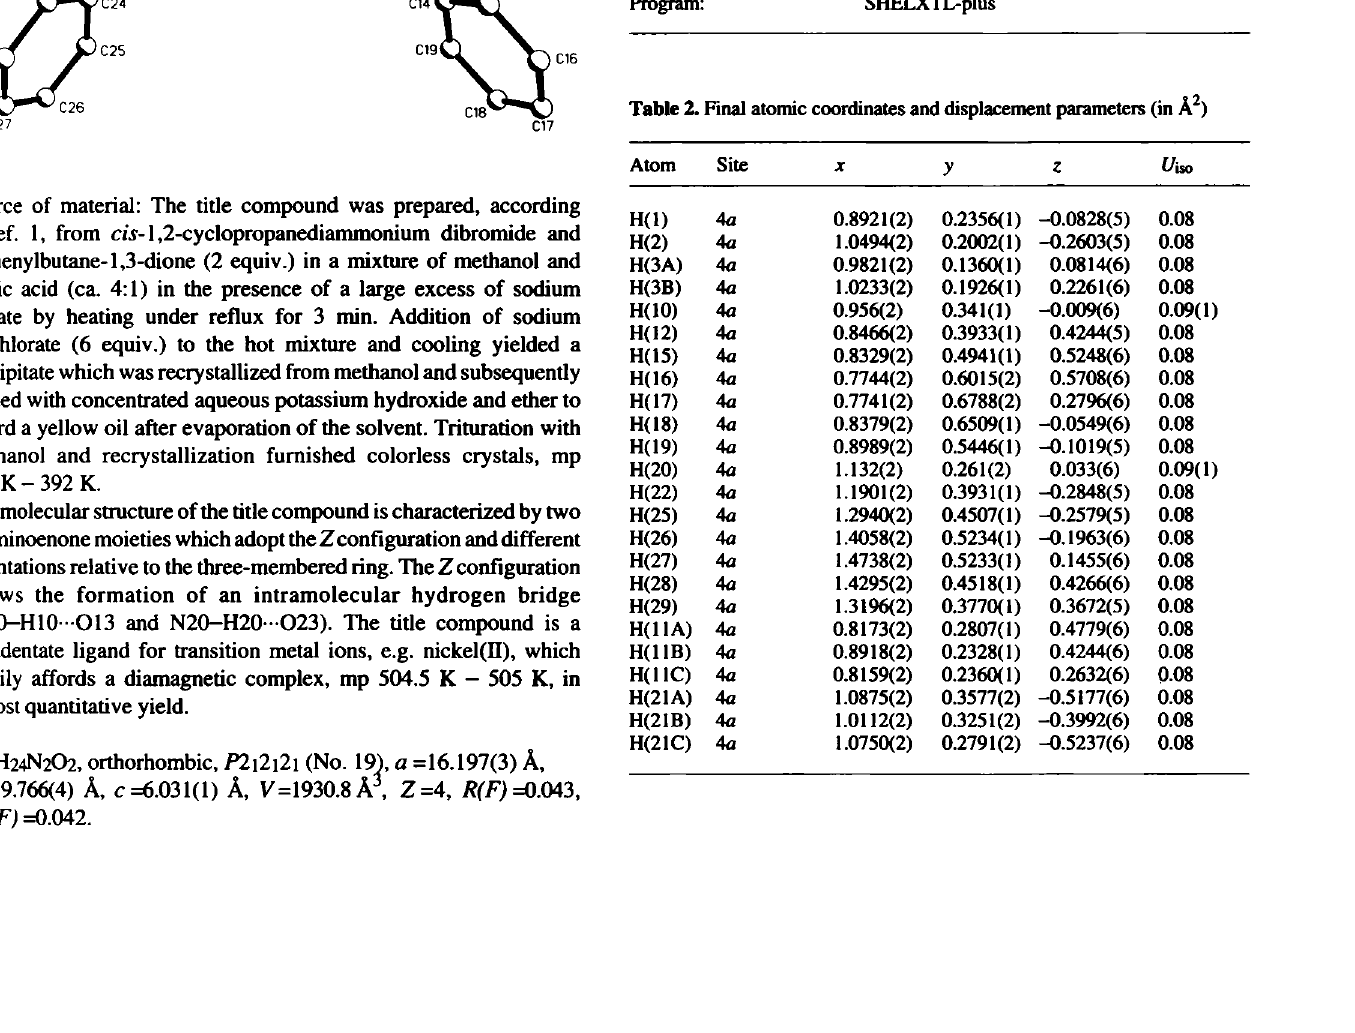
Table 1. Parameters used for the X-ray data collection Crystal: